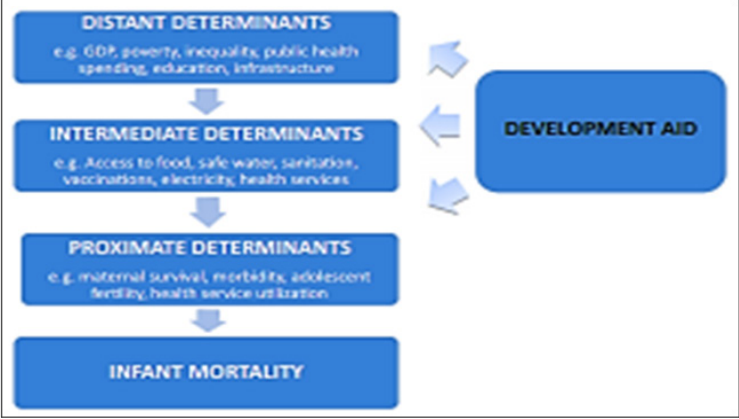
Figure 4: Transmission of the Effects of ODA on Infant Mortality in Asian Countries Source: Schell et al. (2007: 290) and Sartorius and Sartorius (2014: